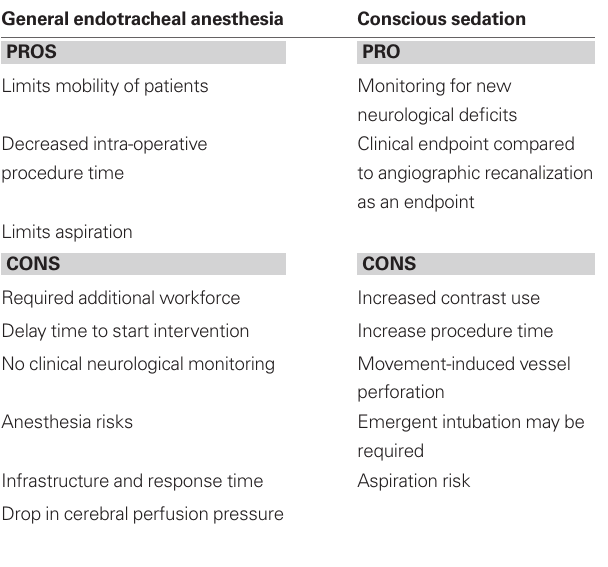
Table 2 | Pros and cons of general anesthesia during acute ischemic stroke